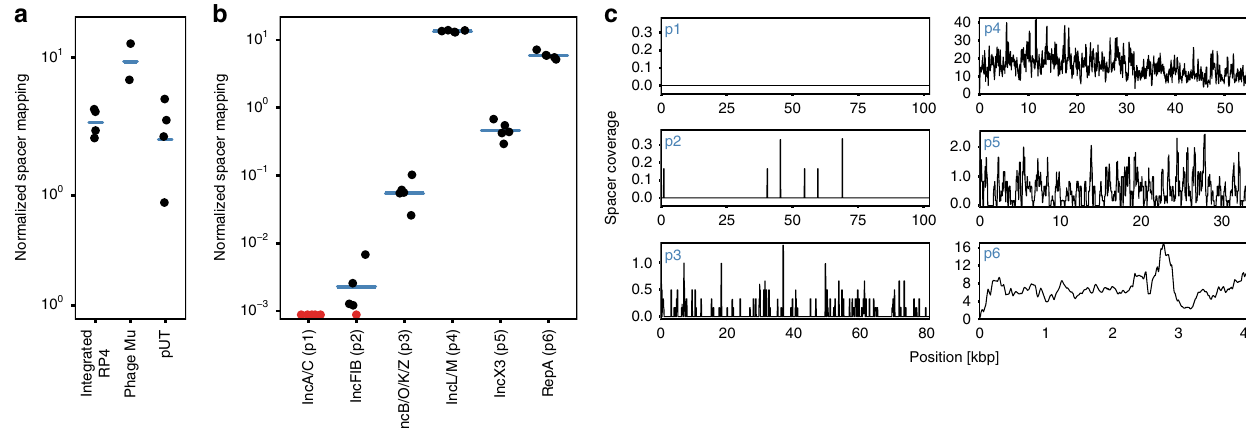
Fig. 2 Detecting non-replicative and complex HGT events. a EcRec acquires spacers from transferrable but non-replicating DNA elements in E. coli S17, the integrated RP4, phage Mu and the non-replicating plasmids pUT. In total 77,825 spacers were obtained. The normalized spacer mapping is spacers per kb per 1000 exogenous spacers. ( n = 4 biological replicates with mean bar, recorded for 6 h). b Recorded spacers from Ec70 carrying six plasmids (p1 – p6). For each plasmid the number of matching spacers is normalized as spacers per kb per 1000 exogenous spacers. Red data points denote zero recorded spacers. No spacers are recorded from plasmid p1 ( n = 5 biological replicates with mean bar, recorded for 6 h). c Mapping of recorded spacers to the plasmid sequences, substantial coverage is seen for all plasmids except the large plasmids p1 and p2 (spacer coverage is average coverage per bp. in 200 bp. windows, based on 5 biological replicates).